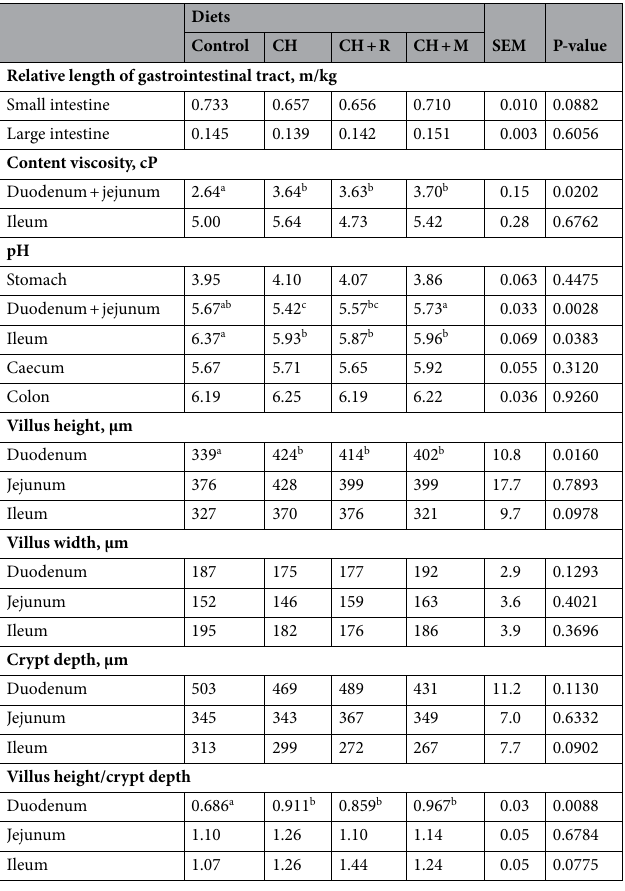
Table 3. Effect of diets on gastrointestinal tract variables and intestinal morphology of piglets. Control = control diet; CH = Chlorella vulgaris diet; CH + R = C. vulgaris diet supplemented with Rovabio® Excel AP; CH + M = C. vulgaris diet supplemented with a pre-selected enzymatic mixture. a,b,c Values within a row with different superscripts differ significantly at P <